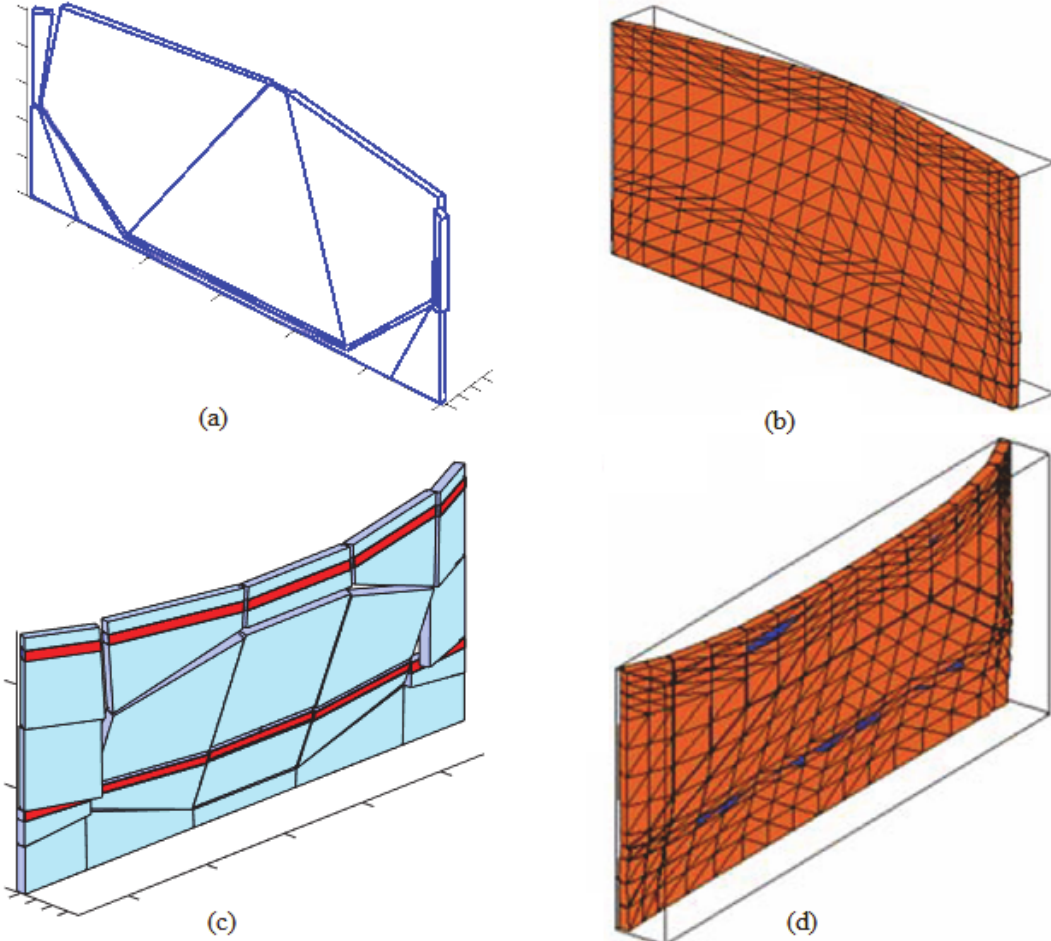
Figure 8: SB01 masonry panel without openings tested in [51]. (a-c) Unreinforced and reinforced case, respectively: collapse mechanism with the GA-NURBS approach; (b-d) Unreinforced and reinforced case, respectively: collapse mechanism with the homogenized FE limit analysis proposed in